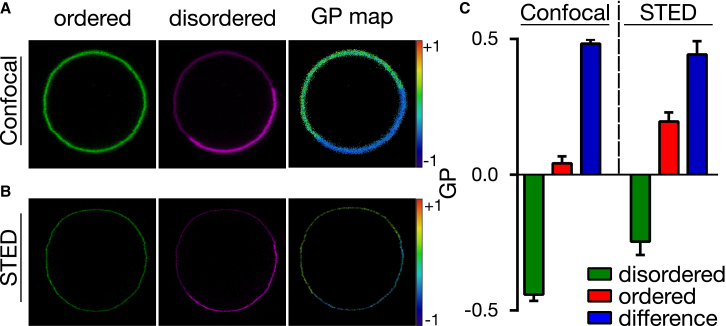
STED GP imaging of micronscale phase-separated GPMVs prepared using high DTT concentration (30 mM) and labeled with Di-4-AN(F)EPPTEA. (A and B) Shown here are confocal (A) and STED (B) microscopy images (20 × 20 μm; green, 520–570 nm, ordered channel; magenta, 650–700 nm, disordered channel) of a phase-separated GPMV and (right) GP map created therefrom. Red-to-blue color code: GP values from maximally ordered (red, +1) to maximally disordered (blue, −1). (C) Given here are the average and SD (error bars) of GP values determined from the ordered (red) and disordered (green) phases of at least 10 GPMVs imaged in confocal and STED mode, and respective differences in GP values between the phases (blue). To see this figure in color, go online.